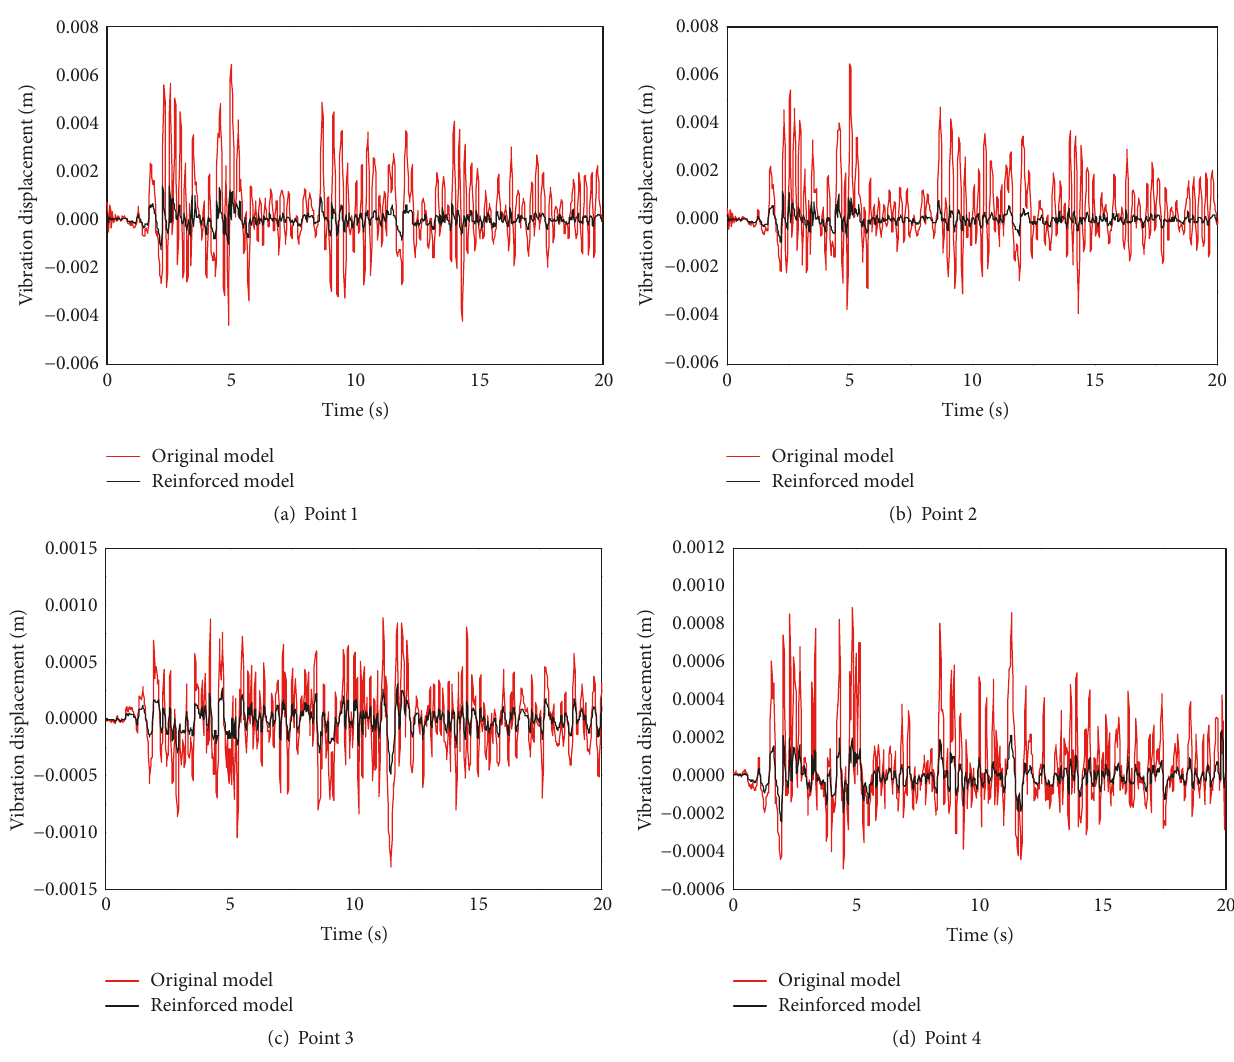
Figure 14: Dynamic responses of observed points on the reinforced masonry in time-domain.